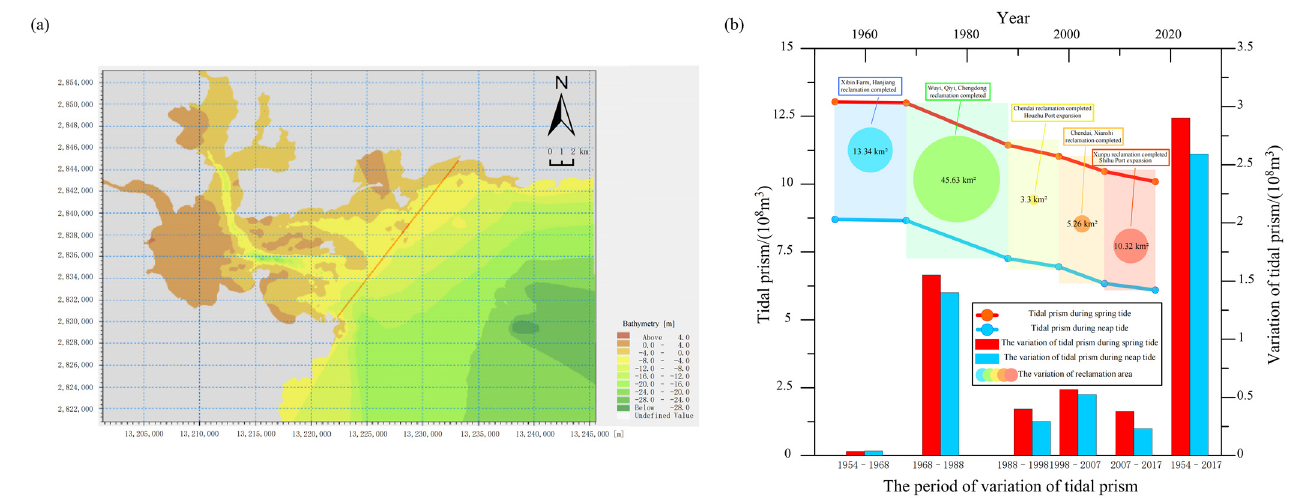
Figure 4. Tidal prism in different periods. ( a ) The calculation range of the tidal prism. ( b ) The tidal prism of Quanzhou Bay in different periods and reclamation at the same time.